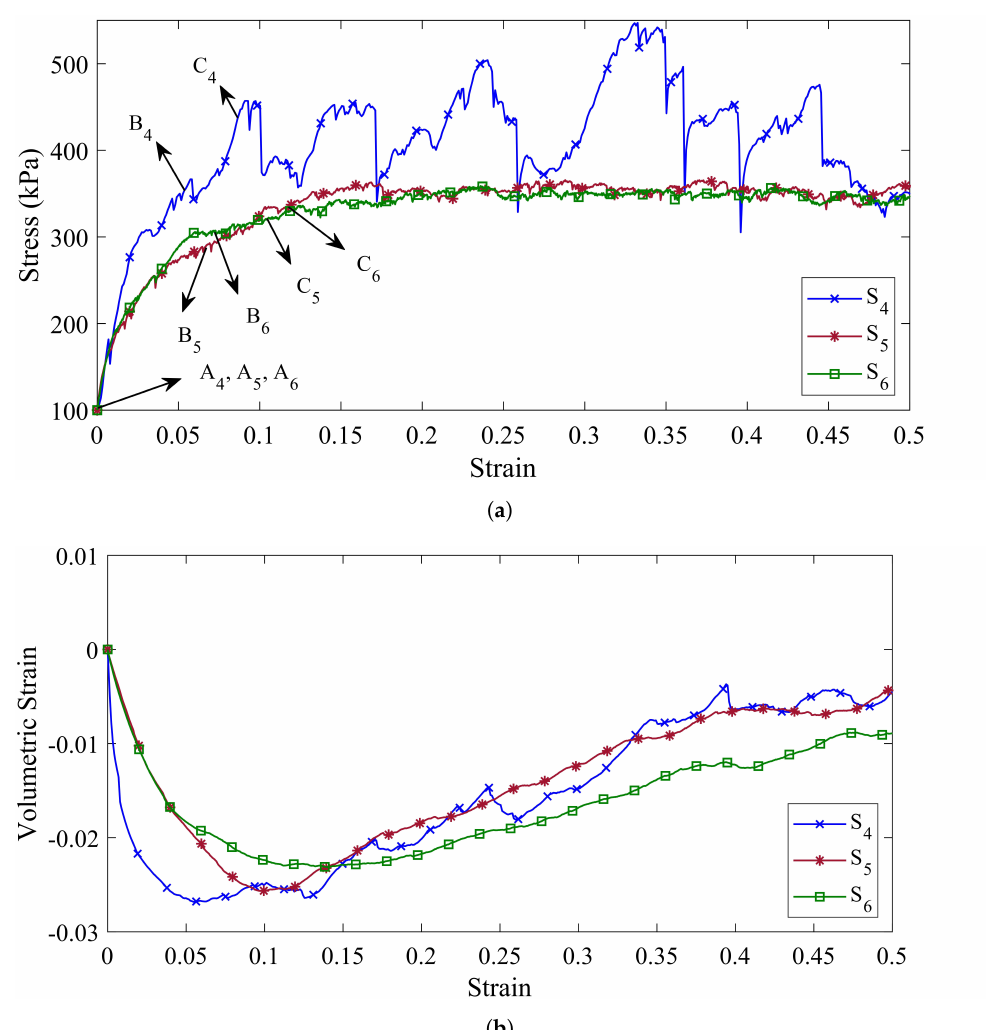
Figure 6. ( a ) The shear stress behavior and ( b ) the volumetric strain behavior of the specimens with different particle size distribution and rolling resistance ( η r = 0.5) (Specimen S 4 is composed of 4– 8 US Mesh coke particles, specimen S 5 is composed of 4–8 US Mesh and 8–14 US Mesh coke